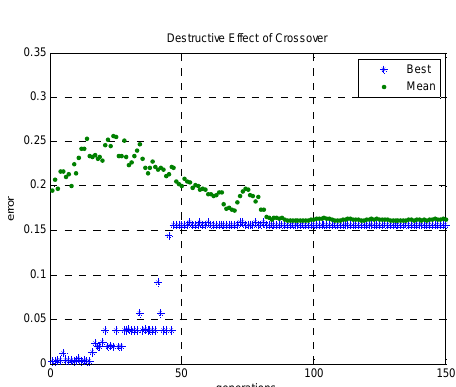
Fig 5: Convergence of a GA